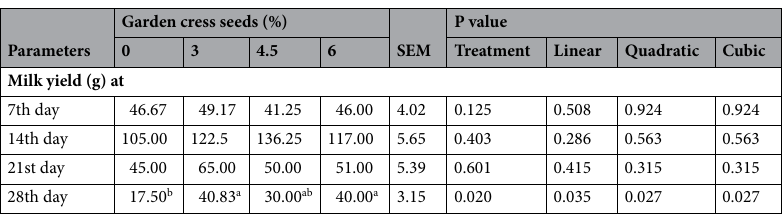
Table 4. Effect of dietary levels of garden cress seeds on milk yield of doe rabbits. SEM stander error means. Means with different superscripts in the same row are significantly different (p <